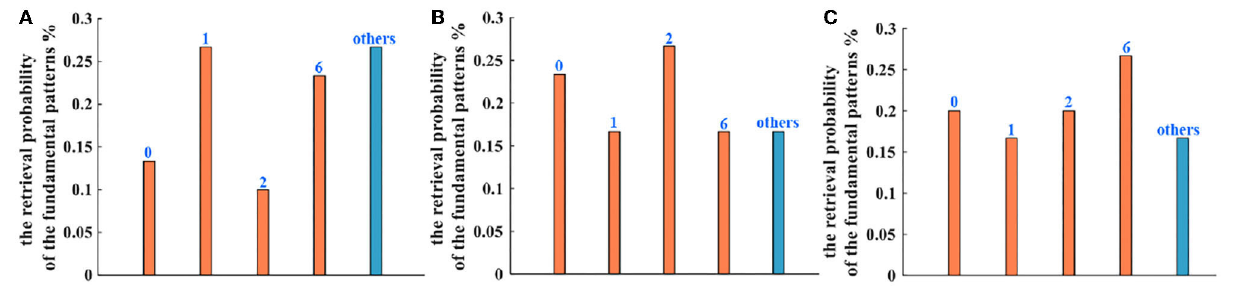
FIGURE 13 | The comparison of retrieval probability of the fundamental memory patterns between (A) the Hopfield network, (B) the IZH oscillatory network, and (C) the MIZH oscillatory network.